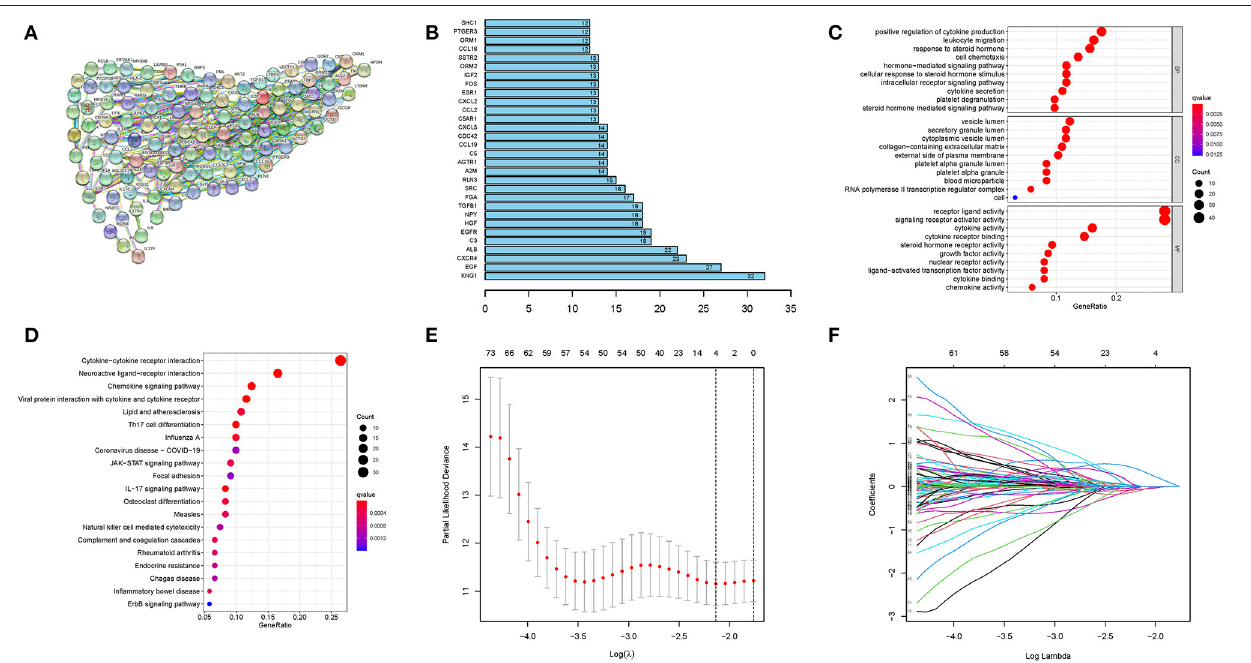
FIGURE 1 | Construction of prognostic model. (A) PPI network and (B) the top 30 genes with enriched functional partners. (C) GO and (D) KEGG bubble graph. (E) and (F) LASSO Cox regression.